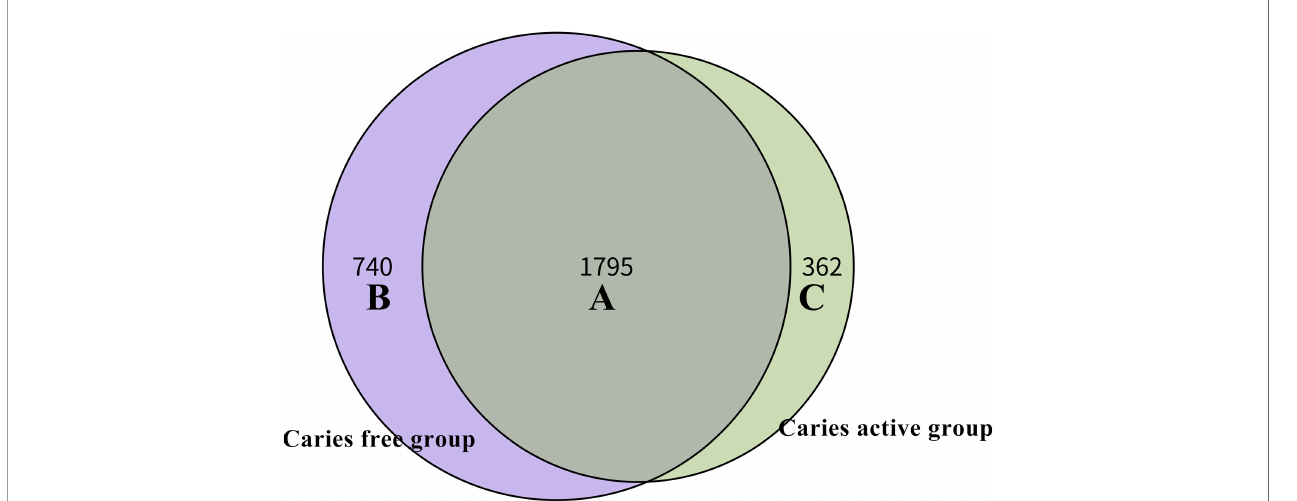
FIGURE 3 | Venn diagram at the species level. The overlap region A represents the microbiome shared in all samples among caries-active and caries-free groups. Region B represented the unique taxa in caries-free controls and Region C represented the unique taxa in caries-active group.